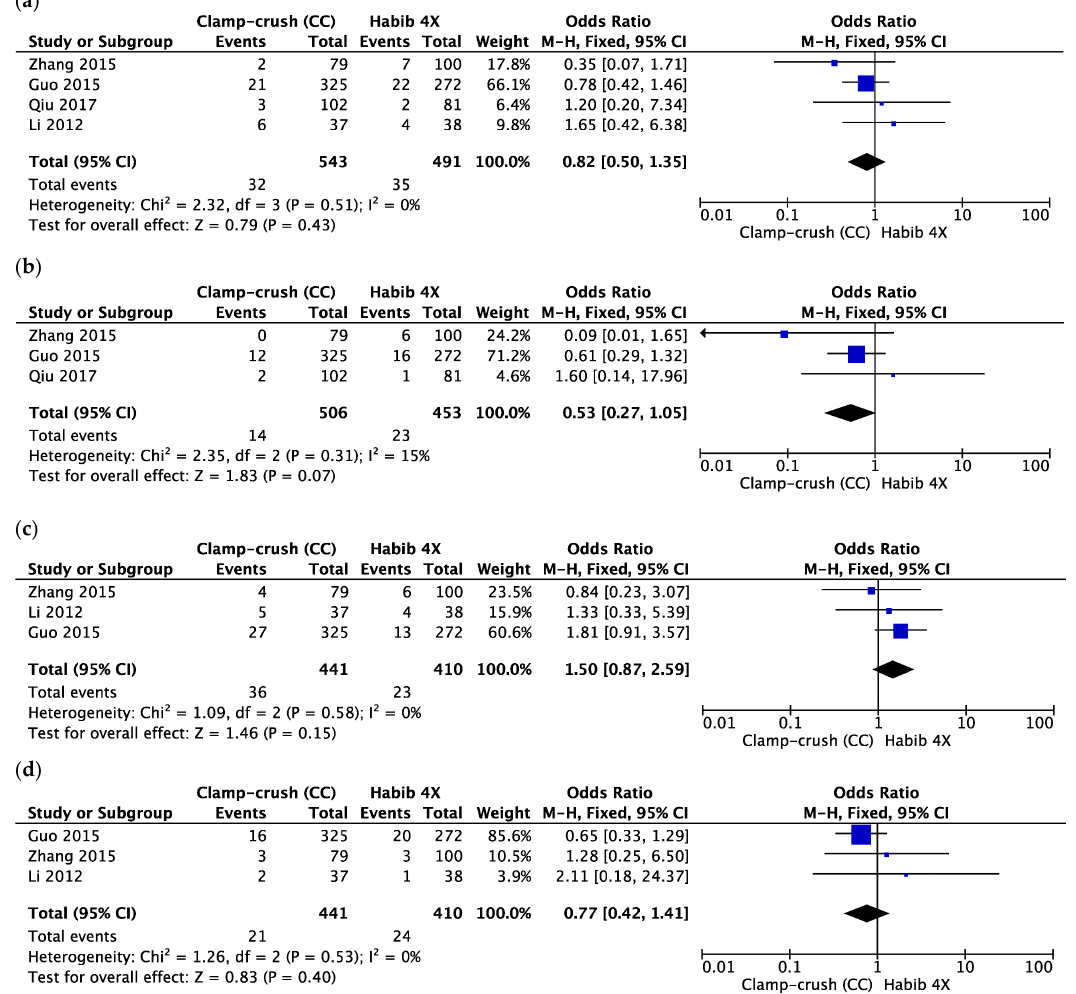
Figure 4. Forest plot representing the ( a ) bile leakage, ( b ) post-hepatectomy liver failure (PHLF), ( c ) pleural effusion and ( d ) abdominal abscess following liver resection comparing the control group (clamp-crush) with the study group (Habib™-4X). Squares’ size depicts effects while comparing the weight of the study in the meta-analysis. The diamond shows no favour towards any study group following analysis. The 95 percent confidence interval is represented as horizontal bars.